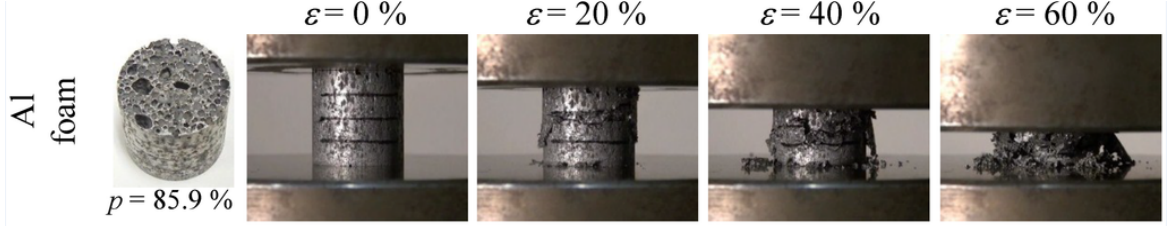
Figure 10: Aluminum foam specimen after pressure test